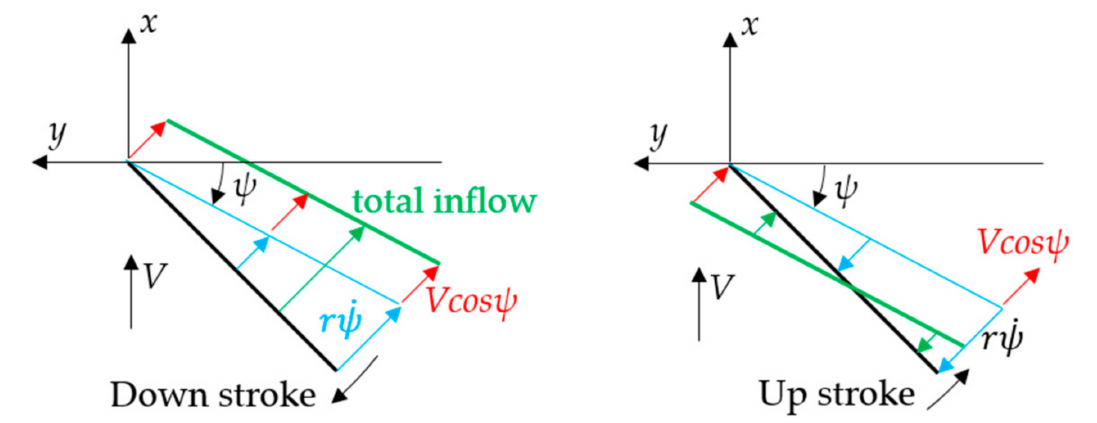
Figure 14. The contribution of the free-stream inflow to the total inflow to a wing during down- and